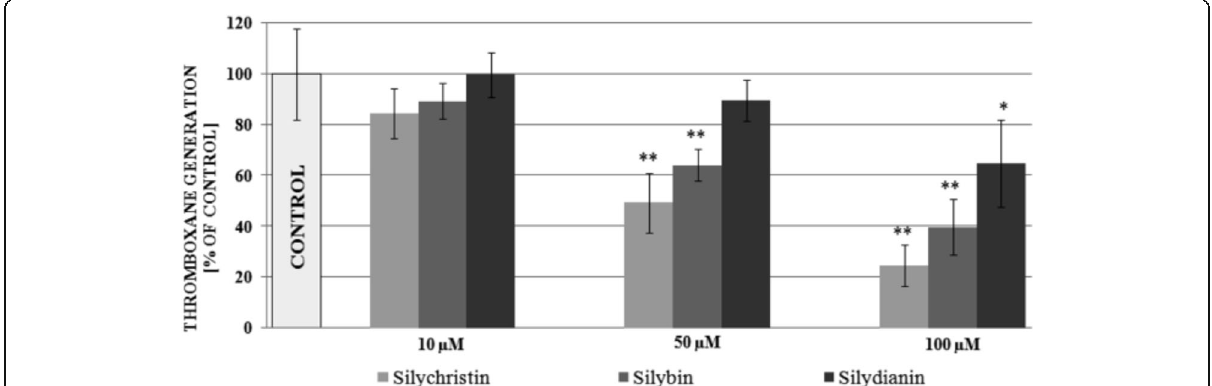
Fig. 2 The effect of flavonolignans (silychristin, silybin and silydianin at concentrations 10; 50 and 100 μ M) on TXA 2 generation in blood platelets.